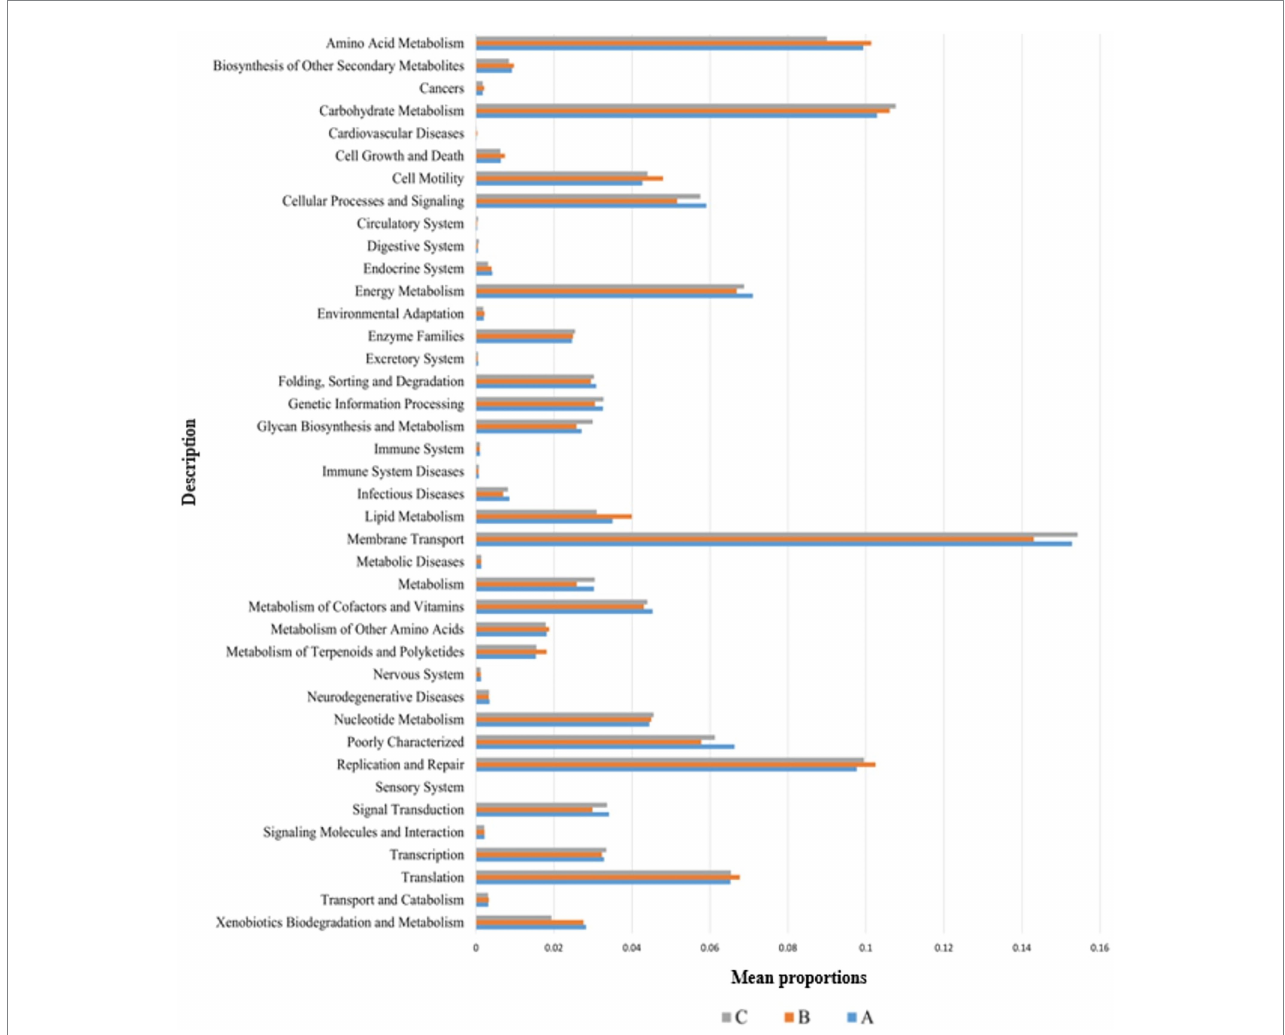
FIGURE 8 Wilcoxon test result map of pathway difference (KEGG level 2). The horizontal axis represents the relative abundance of each group, and the vertical axis represents the function of statistically significant differences. Abundance has no unit.